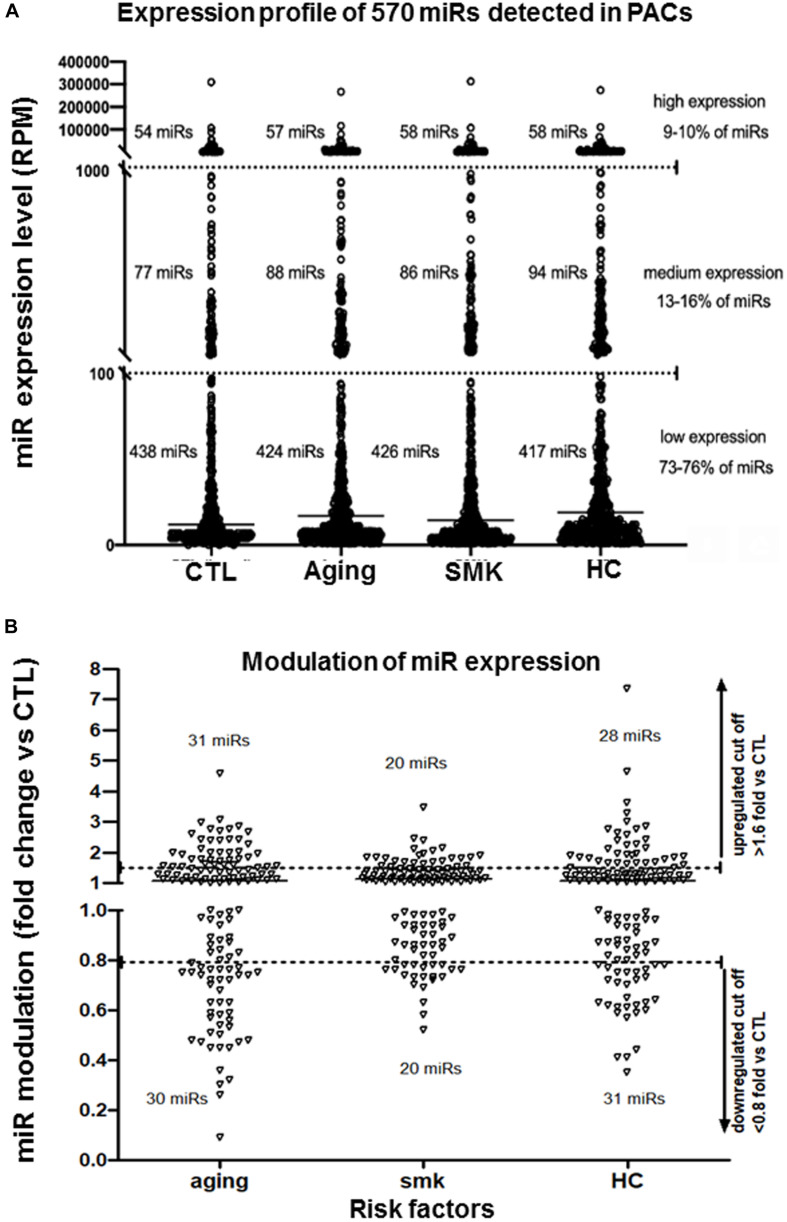
Effect of aging, smoking (SMK), and hypercholesterolemia (HC) on the global expression levels of miRs in PACs. (A) Global evaluation of miR expression levels [reads per million of reads mapped (RPM)] in PACs isolated 2 days after hindlimb ischemia in aging, SMK, and HC mice compared to control mice (CTL). (B) Specific effect of aging, SMK, and HC on the modulation of miR expression. miRs with an expression level of at least 100 RPM are shown in each condition (pool of four to six mice per condition). Arbitrary cutoff levels of 0.8-fold (for downregulated miRs) and 1.6-fold (for upregulated miRs) are indicated.